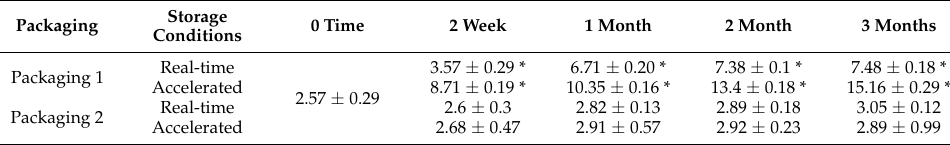
Figure 4. The physical appearance of paracetamol instant jelly samples stored in packaging 1 under ( a ) real-time conditions and ( b ) accelerated conditions and samples stored in packaging 2 under ( c ) real-time conditions and ( d ) accelerated conditions at different time points (0, 2 weeks, 1, 2, and 3 months). Table 3. The moisture content of paracetamol instant jelly in dry form stored in packaging 1 and packaging 2 at different time points (0, 2 weeks, 1, 2, and 3 months). * symbol indicates significant differences ( p -value <